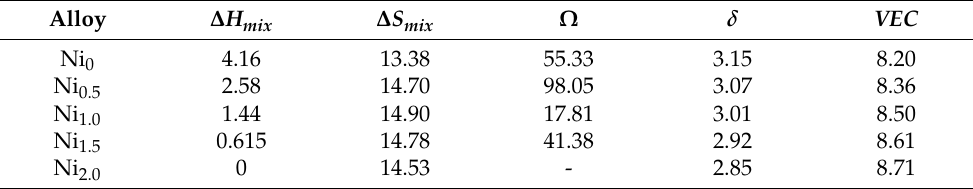
Table 1. Thermodynamic parameters of CoCrCuFeMnNi x HEA